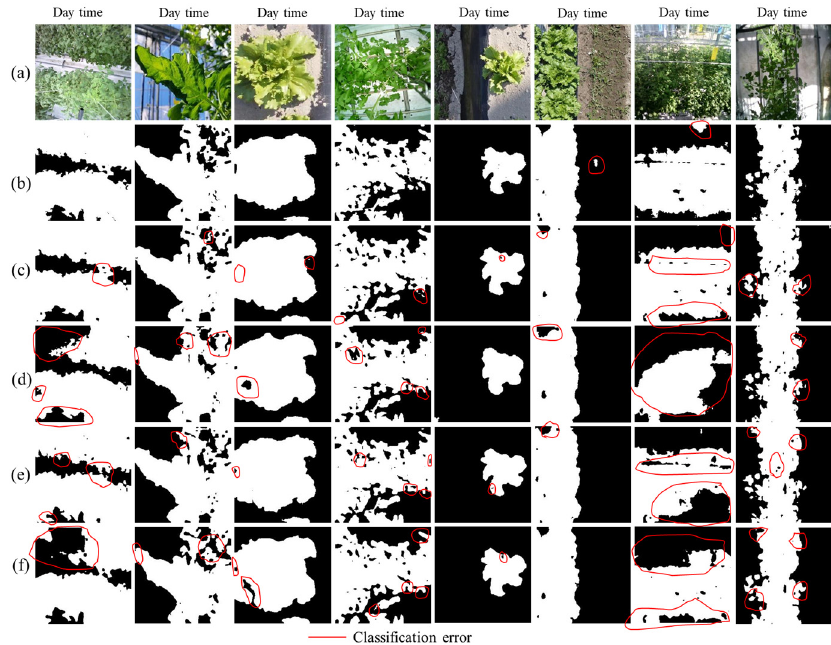
Figure 11. Visualization of the challenges for semantic segmentation of crops (RGB) grown in plant factory and open field: ( a ) RGB image of tomato and lettuce; ( b ) ThelR547v1 predicted ground truth image; ( c ) Deeplabv3plusInceptionresnetv2 predicted ground truth image; ( d ) Deeplabv3plusXceptionNet predicted ground truth image; ( e ) Deeplabv3plusResNet50 predicted ground truth image; ( f ) Deeplabv3plusMobilenetv2 predicted ground truth image.